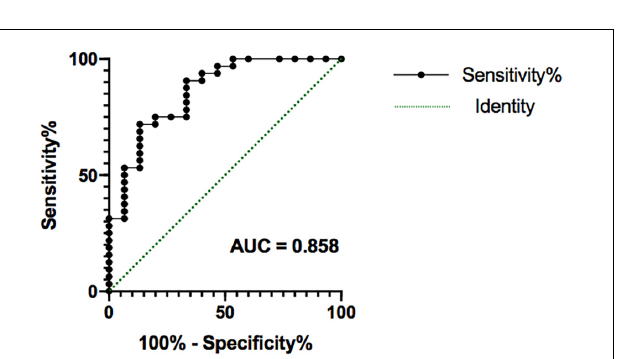
FIGURE 5 | The receiver operating characteristic plot displaying sensitivity and specificity properties for a combined model formed by potential factors (age, sex, right amygdala volume, right amygdala-NAc functional connectivity). This model provided a good prediction of persistent depression obtained after 8 weeks of SG treatment, with area under the receiver operating characteristic curve (AUC) = 0.858 ( p < 0.001). SG, Shugan Jieyu